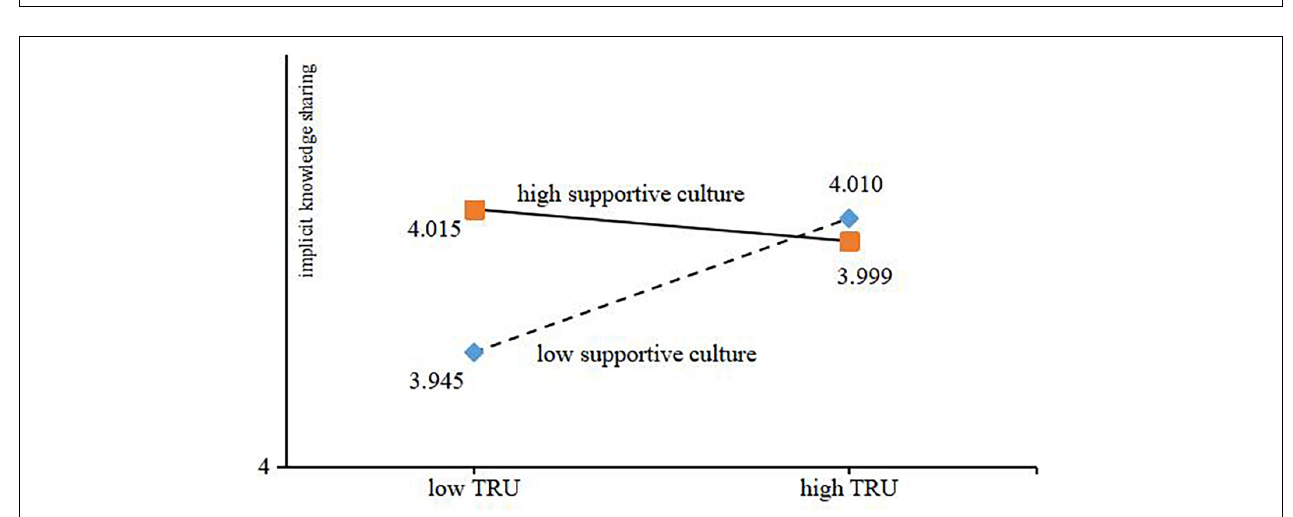
FIGURE 3 | Moderating effect of supportive